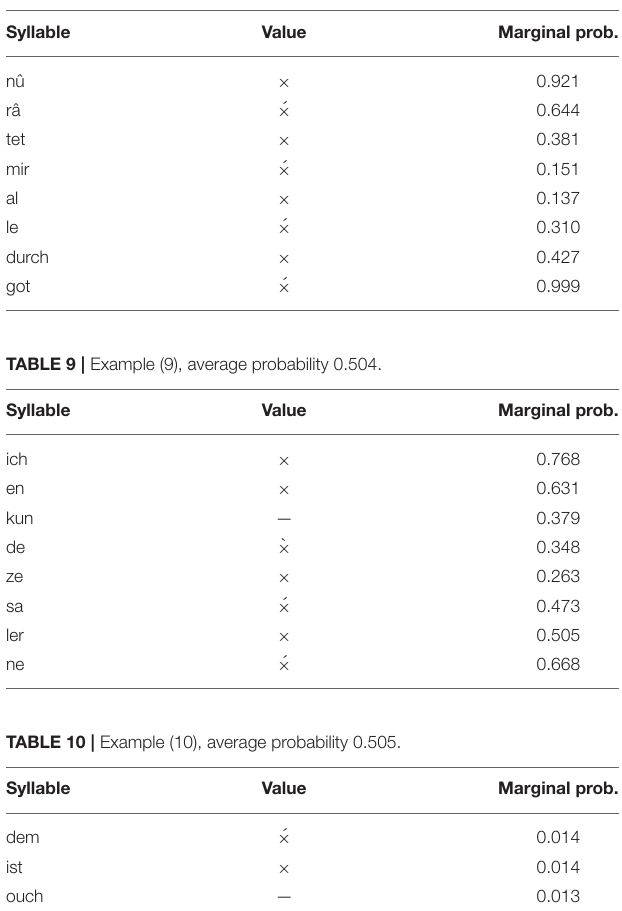
TABLE 8 | Example (8), average probability 0.496.